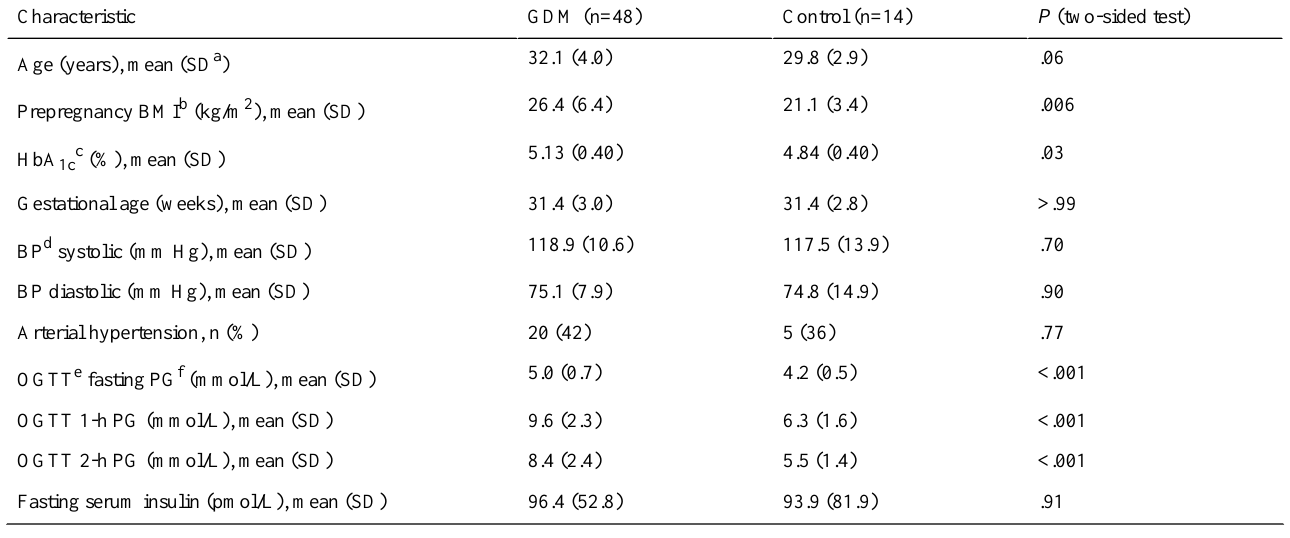
Table 1. Characteristics of the participants (N=62).